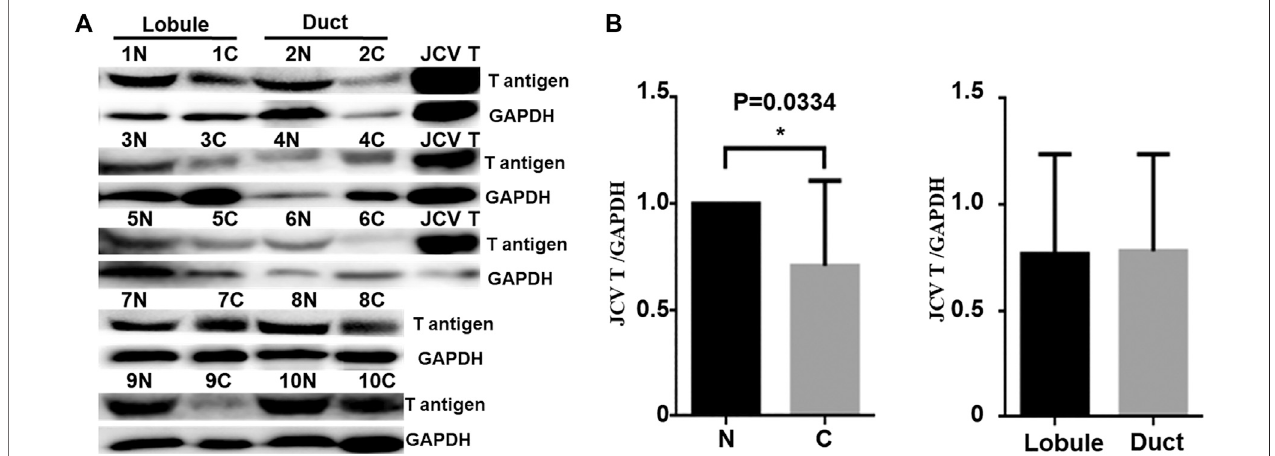
FIGURE4| JCVTantigen expression inhumanbreast cancers. TantigenwasscreenedbyWesternblot (A) and subsequently analyzed by densitometric analysis (B) . N, normal; C, cancer. Positive control, spontaneous breast cancer from JCV T antigen transgenic mouse.